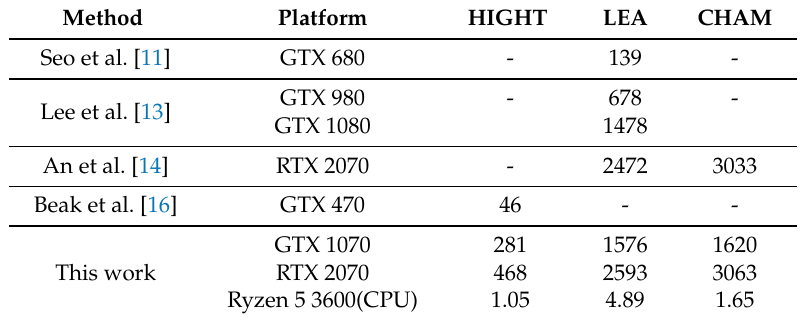
Table 5. Comparison of encryption kernel on GPU in terms of throughput